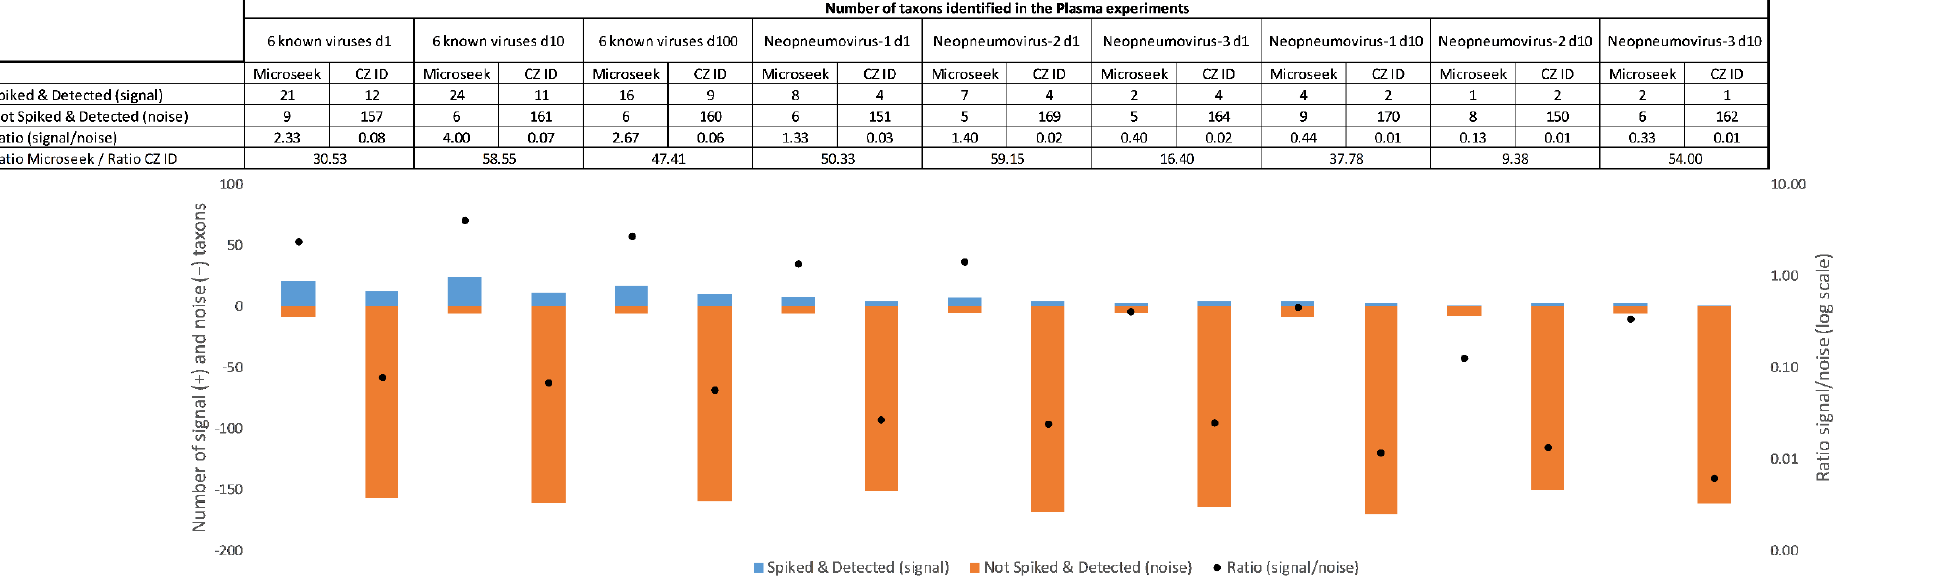
Figure 5. Signal-to-noise ratio in the Plasma experiments. Histograms below the table represent the signal (blue bars with counts above zero on the primary axis) vs. noise (orange bars with counts below zero on the primary axis) and associated signal-to-noise ratios (black dots on the secondary axis).